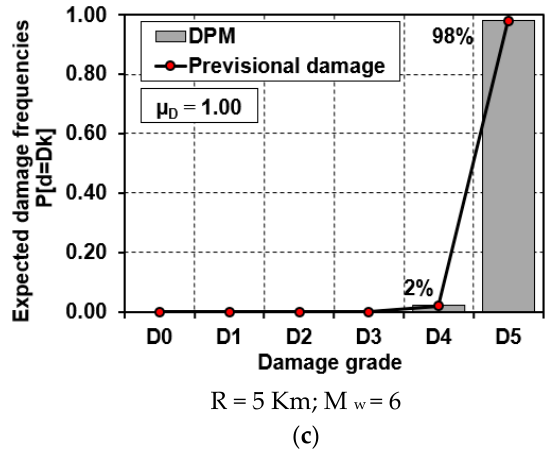
Figure 21. Damage distribution considering local seismic amplification effects.